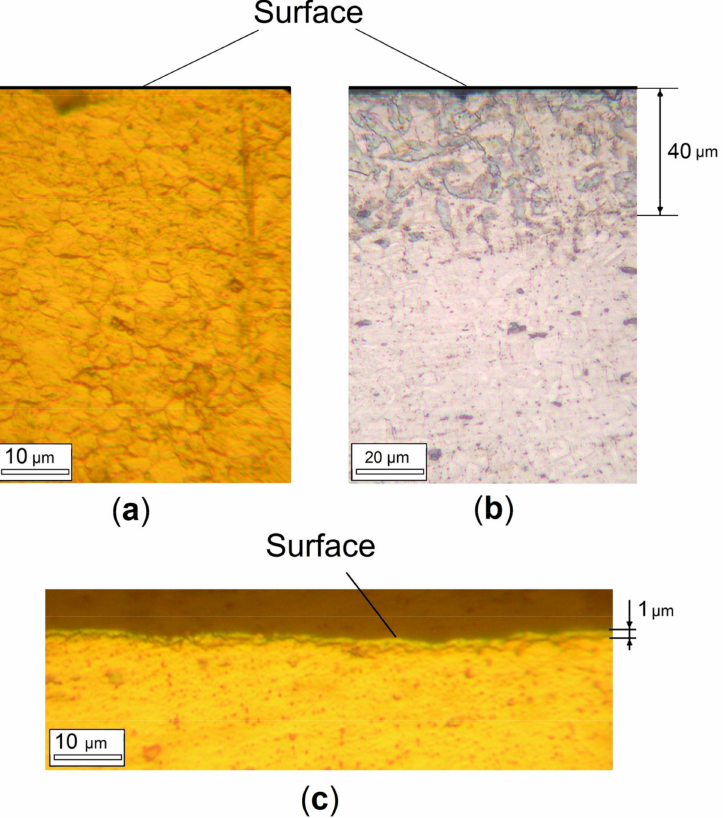
Figure 9. Optical micrographs of initial ( a ) and Al-implanted samples etched with reagent 1 ( a , c ) and reagent 2 ( b